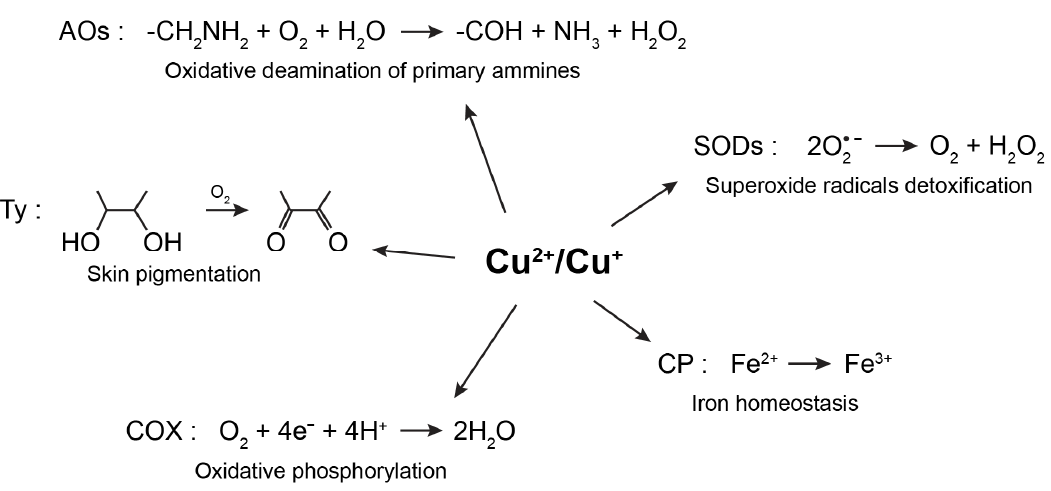
Figure 1. Physiological processes involving the redox activity of copper. Copper is often found as a cofactor in the active sites of enzymes with oxidoreductase activities. AOs—amine oxidases;